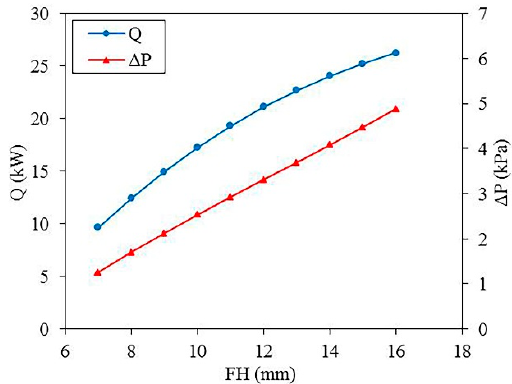
Figure 15. Heat transfer capacity ( Q ) and Δ P separately versus fin height (FH).